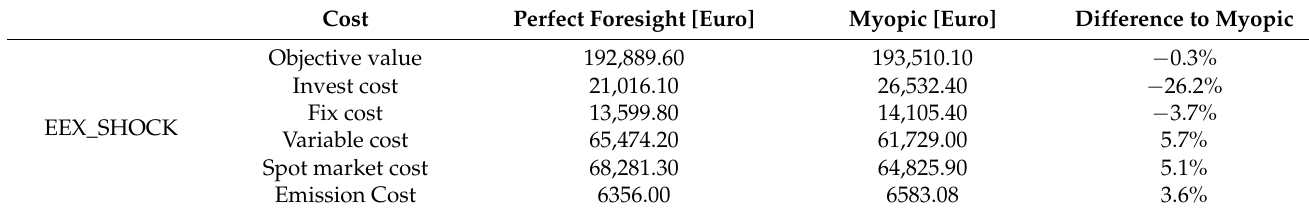
Table 8. Comparison of objective value and costs of the EEX_SHOCK scenario. Cost